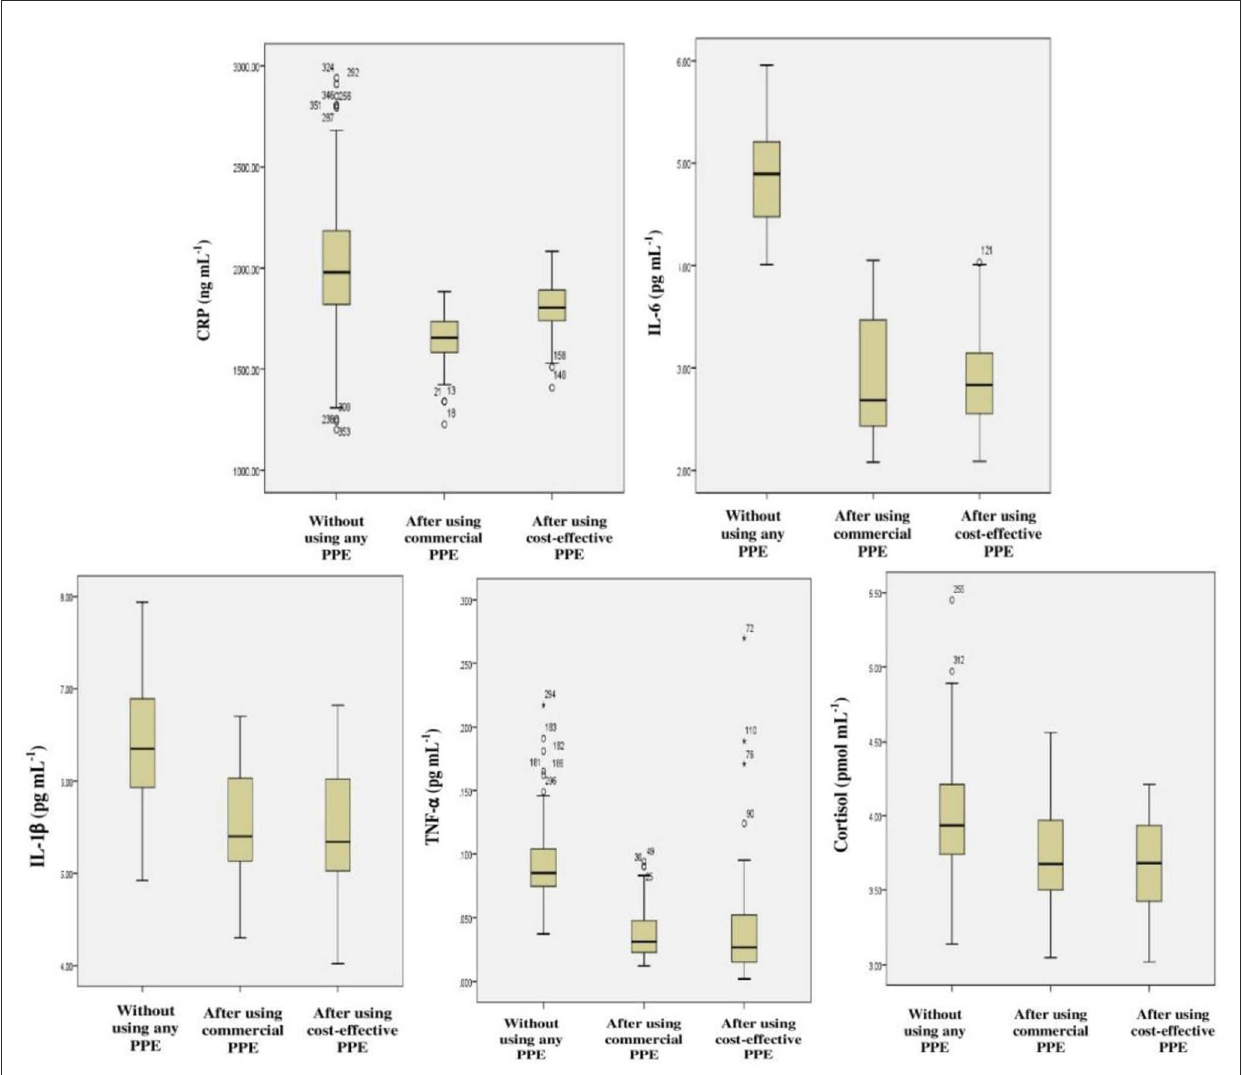
FIGURE7 Frequency distribution for various inflammatory markers among farm-workers not using and after their use of